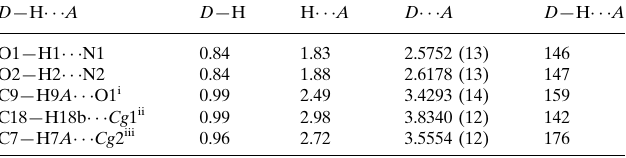
Hydrogen-bond geometry (A˚ , (cid:2)